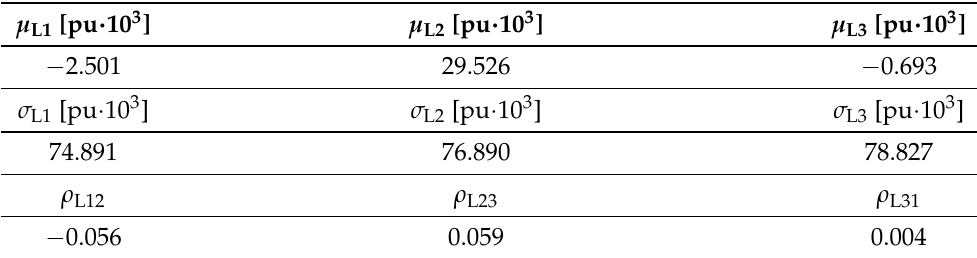
Table 2. Statistical parameters of random